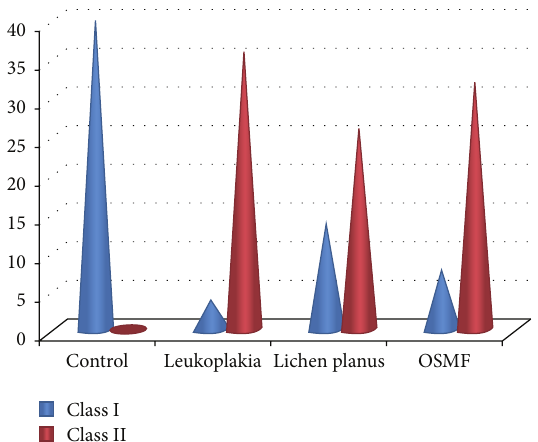
Figure 1: Graphical presentation of Class I and Class II features in